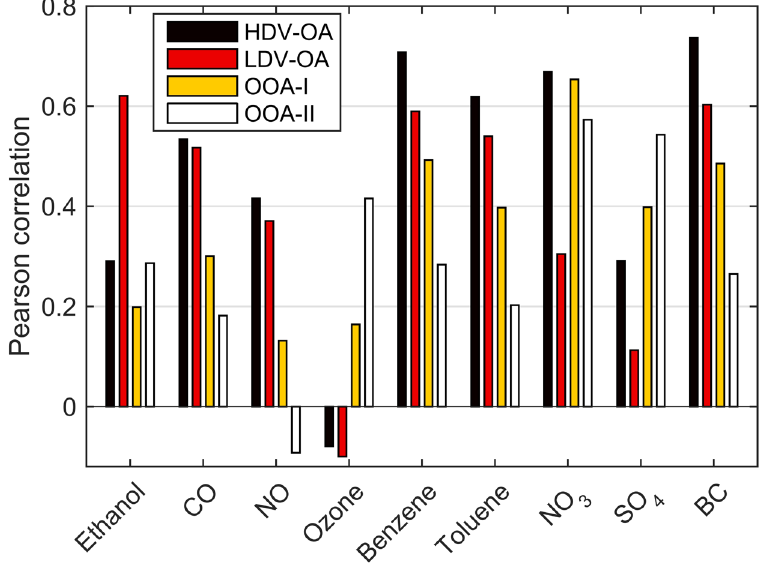
Figure 4. Pearson correlation between external tracers and PMF